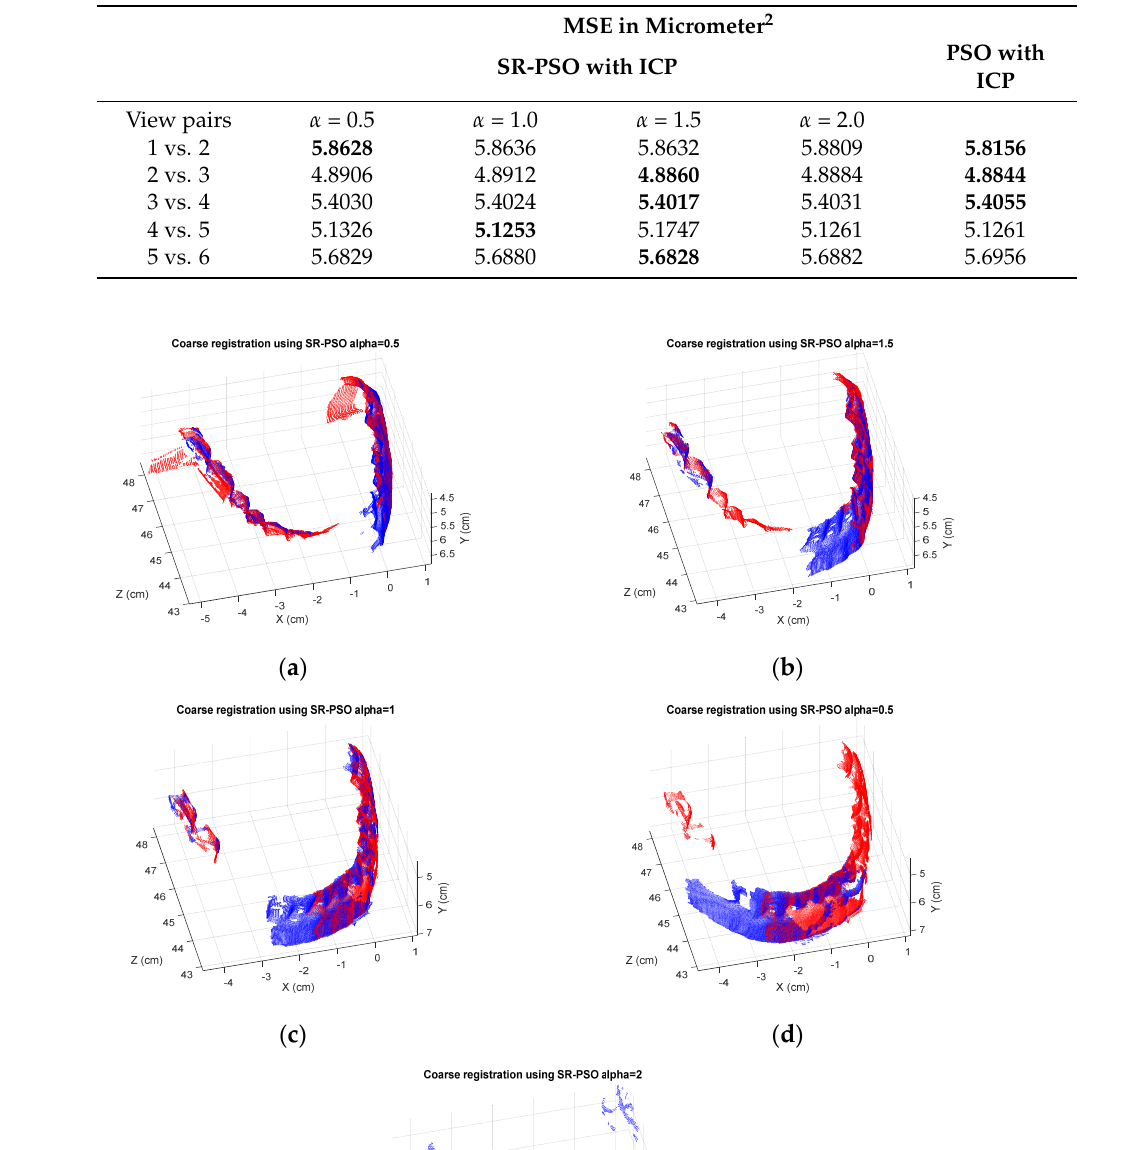
Table 5. MSE from SRPSO and PSO for the regular-tooth model (the best value is in bold and the worst value is underlined). Table 6. MSE from SR − PSO with iterative closet point (ICP) and PSO with ICP for the regular-tooth model (the best value is in bold).